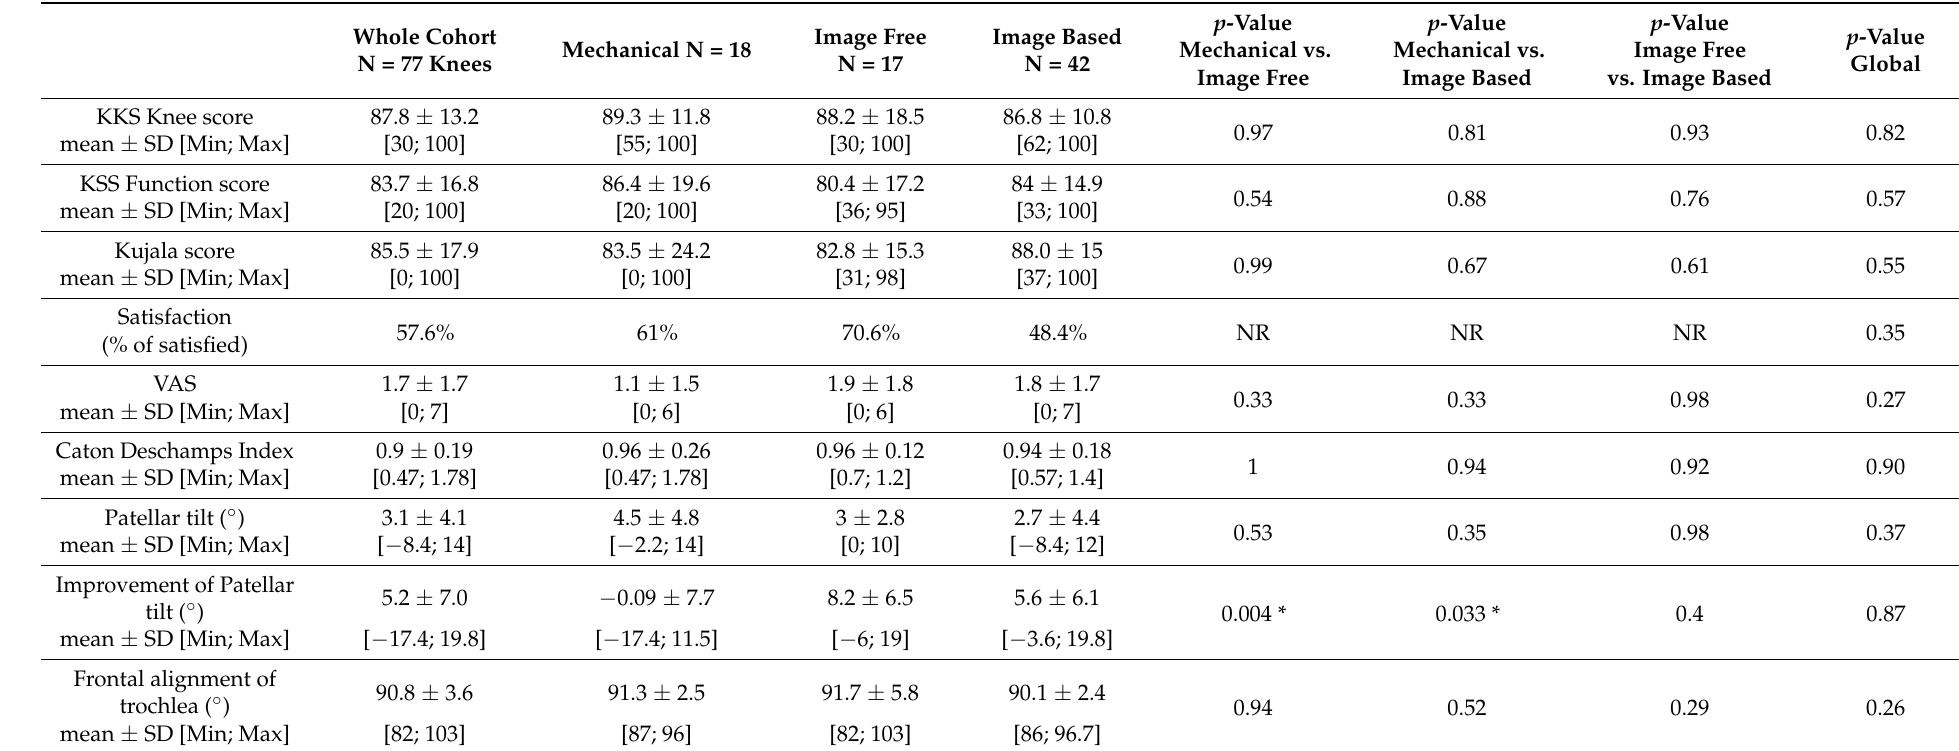
Table 3. Clinical and radiological outcomes at the last follow-up between the three groups. Whole Cohort